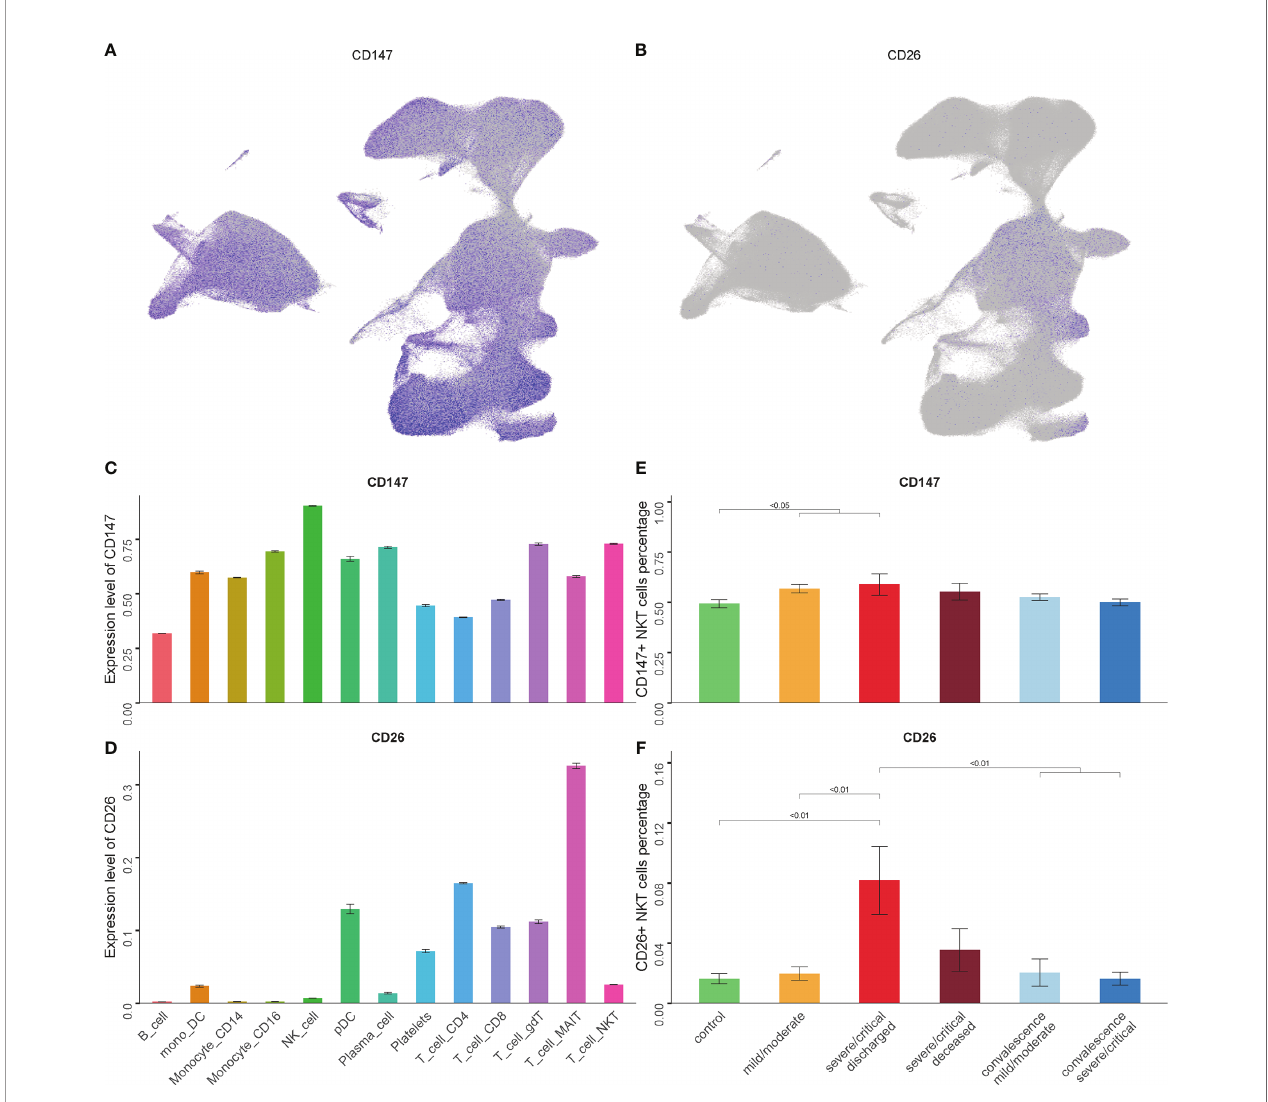
FIGURE 2 | The expression levels of CD147 and CD26 in NKT cells. (A, B) Expression of CD147 and CD26 in PBMCs showing UMAP visualization. (C, D) Expression of CD147 and CD26 in PBMC subsets. (E, F) Percentage of CD147+ NKT cells and CD26+ NKT cells in COVID-19 patients and controls. (Wilcoxon